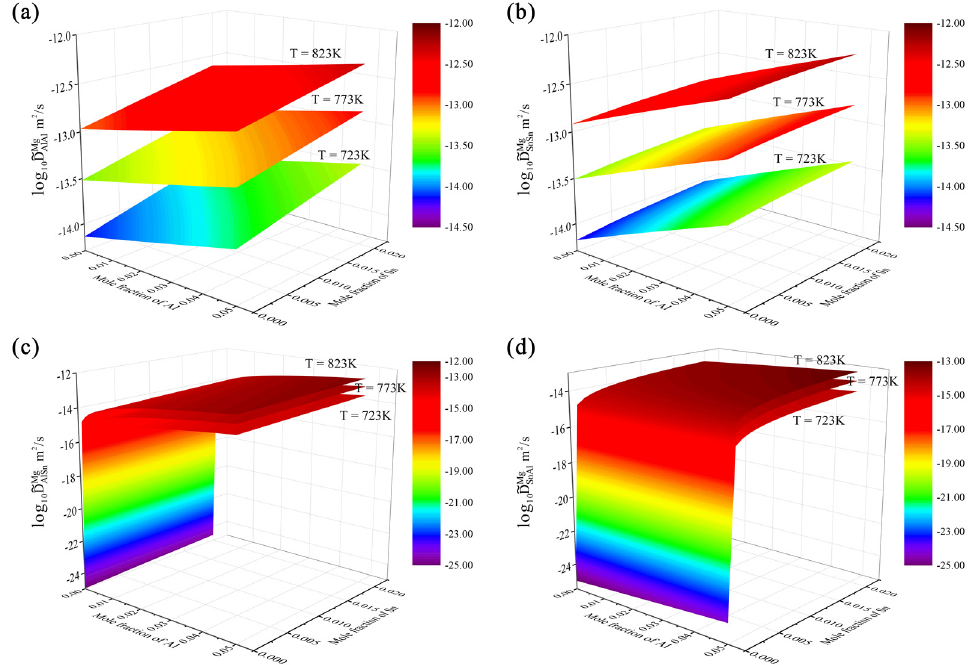
, ( b ) (cid:101) D Mg , SnSn AlAl